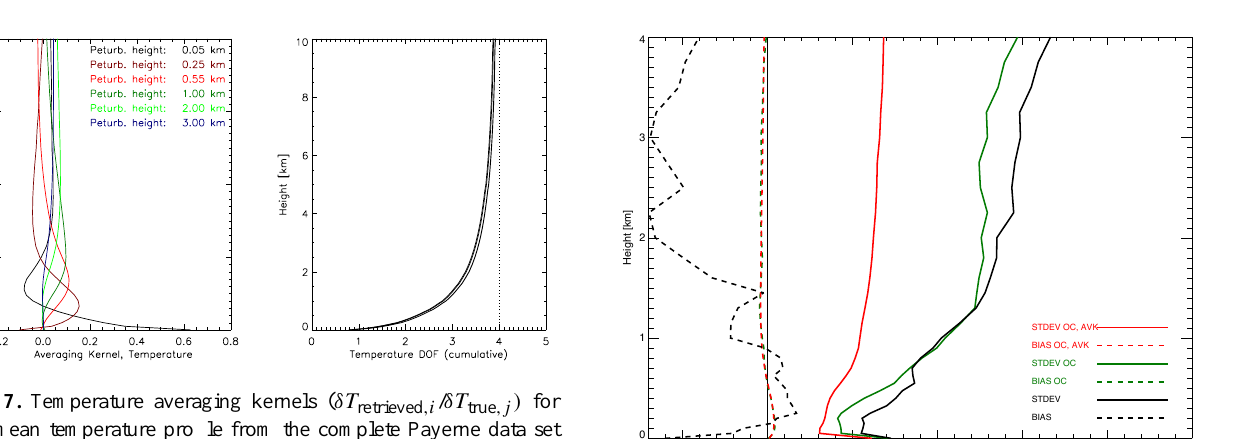
Figure 8 : Temperature profile differences (BIAS and STDEV) during clear-sky conditions from August 2006 – December 2009 between MWR and radiosonde measurements. The MWR retrieval coefficients and the TB-offset correction were derived using exactly the same clear-sky measurements as considered in the evaluation. Black lines show the retrieval results without using the systematic TB offset correction while green lines show the results applying the systematic TB offset correction (OC). Additionally, in red the STDEV is shown after smoothing the radiosonde profile with the averaging kernel (AVK). A total number of 486 matching MWR/radiosonde cases are evaluated in the plot.